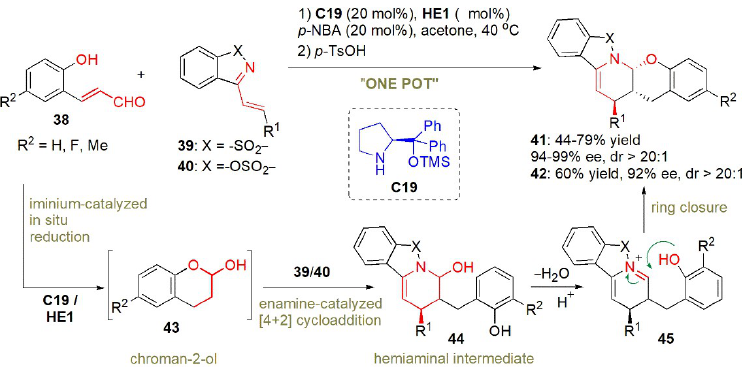
Figure 16. Synthesis of chromane-containing polycyclic compounds